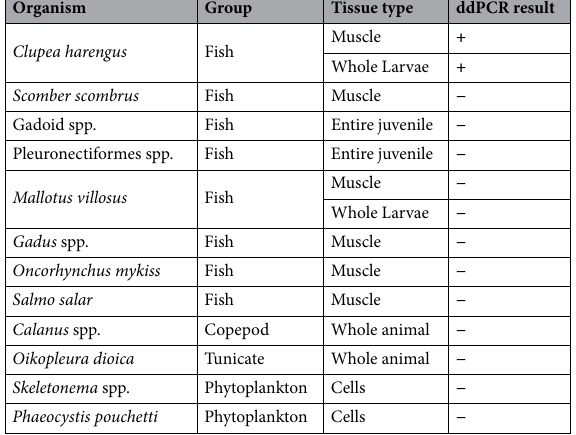
Table 1. Genomic DNA used to confirm specificity of C. harengus ddPCR